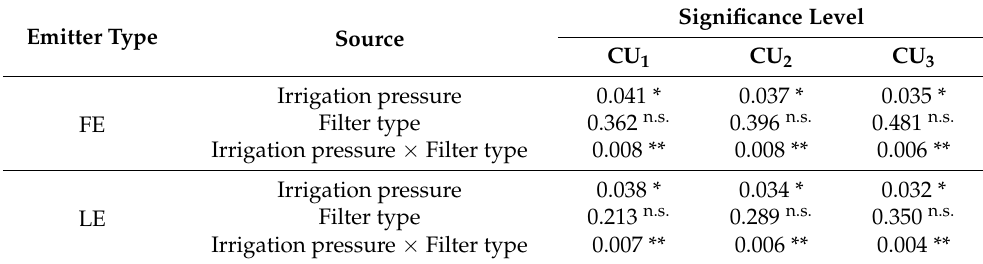
Table 5. Variance analysis of